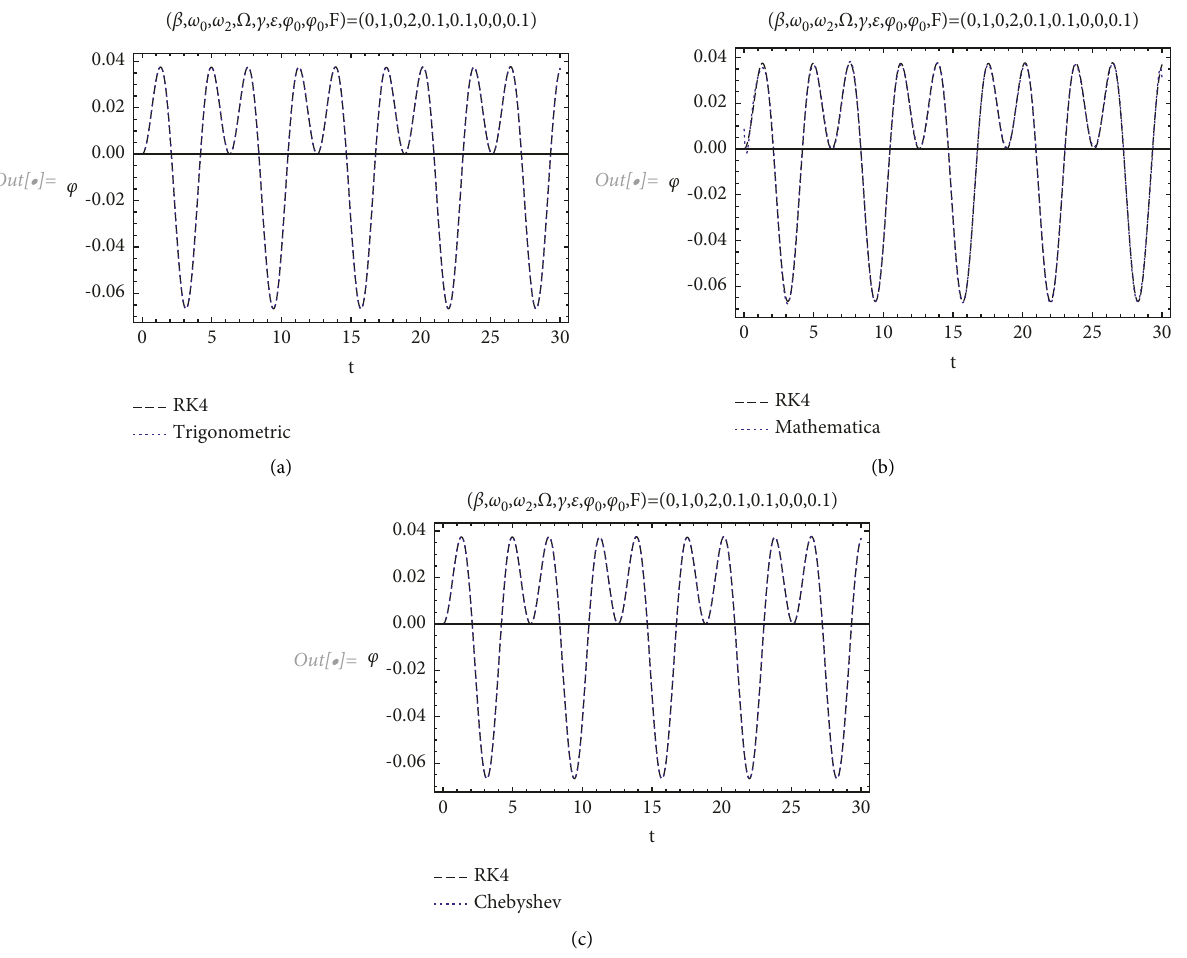
Figure 3: The comparison between the semi-analytical solution (analytical approximation) (16) and the numerical approximations using the Chebyshev collocation method and RK numerical method as well as the MATHEMATICA command Fit to i.v.p. (3) for case (1): β , ω 2 , F 0 , 0 , 0 . 1 ( ) (cid:28) ( )